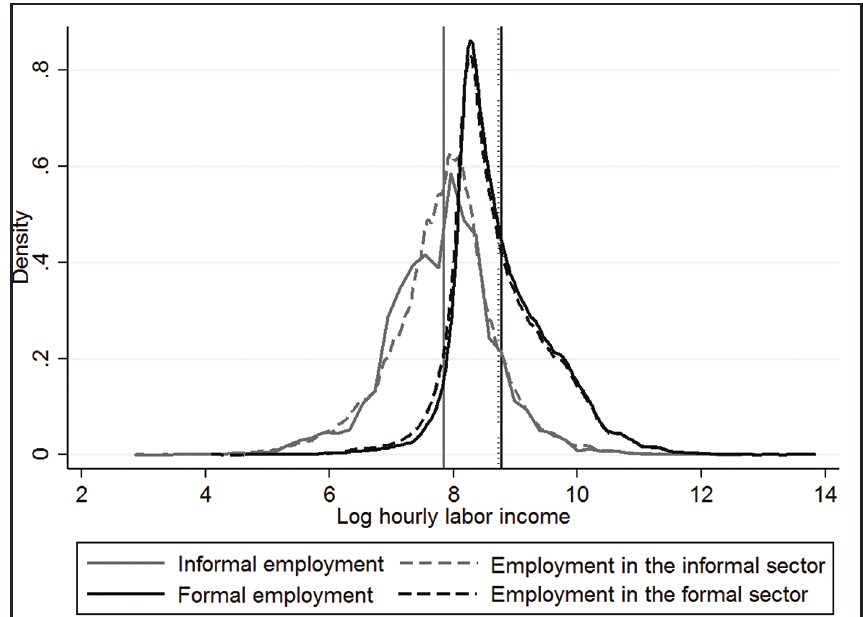
Distribution of log hourly labor income by informality.